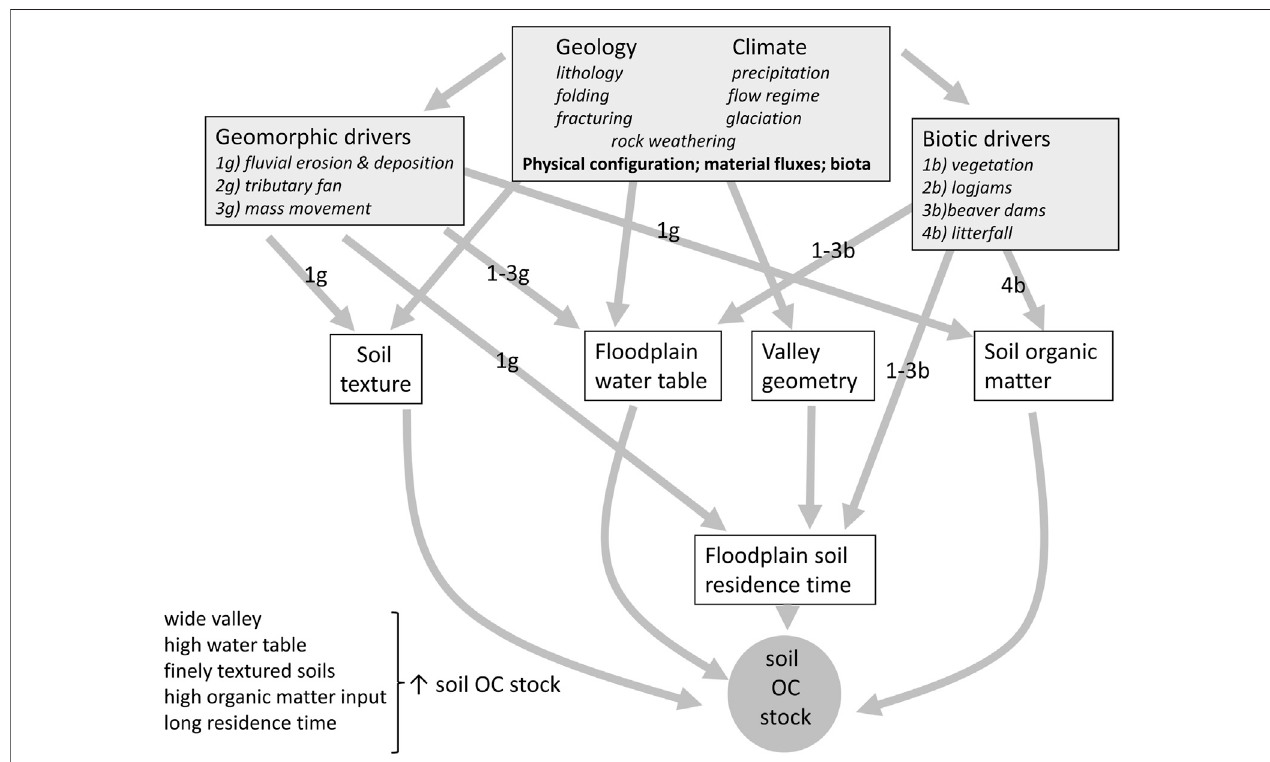
FIGURE 1 | Conceptual model for in fl uences on fl oodplain soil organic carbon stock. The numbers and letters superimposed on arrows represent the speci fi c geomorphic ( “ g ” ) and biotic ( “ b ” ) drivers indicated by each arrow.